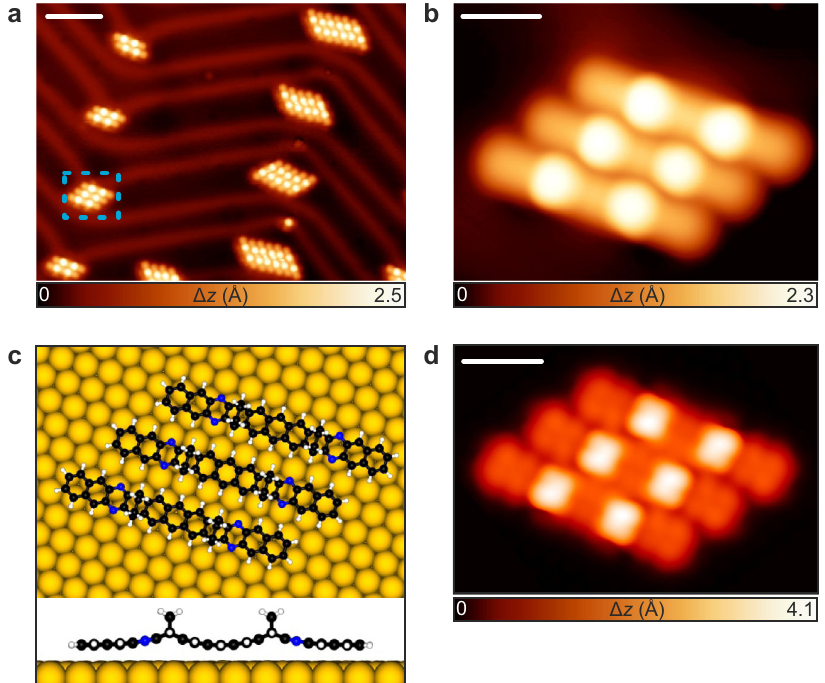
Fig. 2 Identi fi cation of the precursor 5 after deposition on Au(111). a Large-scale STM topography image of the surface after room temperature deposition of 5 . V b = − 1 V, I t = 100 pA, scale bar = 5 nm. Δ z denotes the relative height w.r.t. clean Au(111) surface. b Magni fi ed view of one of the self- assembled structures shown in panel a containing three molecules. V b = − 0.5 V, I t = 50 pA, scale bar = 1 nm. c Top and side views of the DFT equilibrium geometry of a cluster of three molecules 5 on Au(111). d DFT-simulated constant-current STM image of the three self-assembled molecules shown in panel a , V b = − 0.5 V, scale bar: 1 nm.